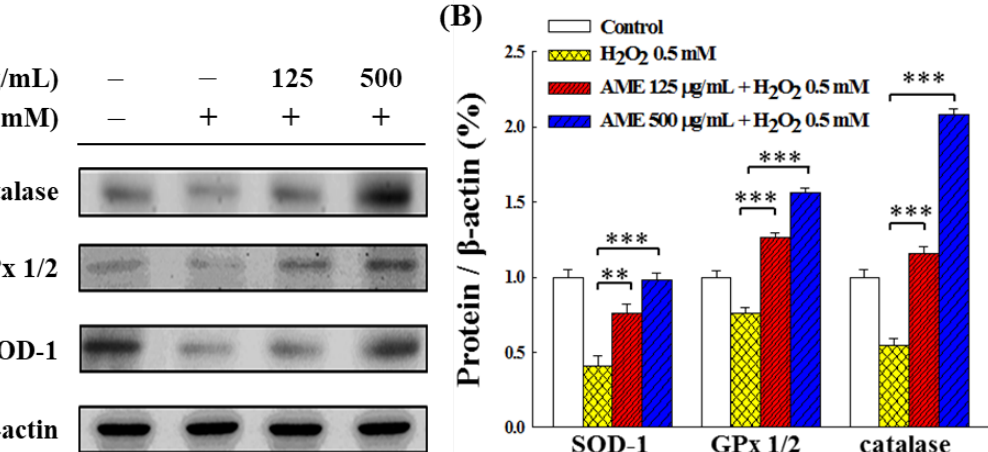
Figure 9. Effect of AME pretreatment on the production of antioxidant enzymes in H 2 O 2 -stimulated PC12 cells. ( A ) Changes in protein formation. ( B ) Densitometric quantitation. The data were estimated from triplicate independent experiments. The control group was the cells grown without treatment with extract sample and H 2 O 2 stimulation. The protein expressed by this group was set as 1.0. The significance of the difference in data compared to the vehicle group is labeled as ** p < 0.01 and *** p < 0.001.